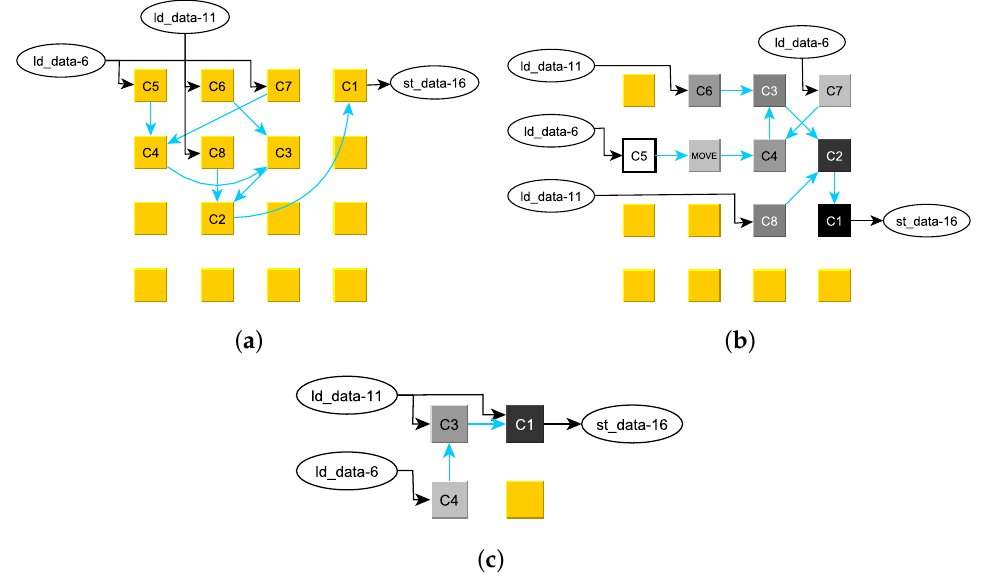
4 PE array, ( b ) optimized placement × 2 PE ×